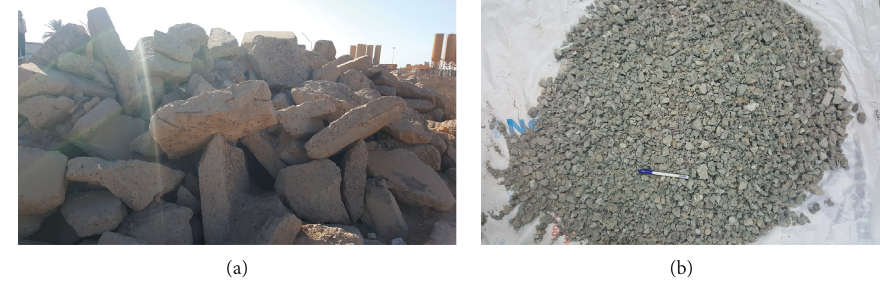
Figure 2: Texas T-wall before and after crushing. Table 2: Physical properties of